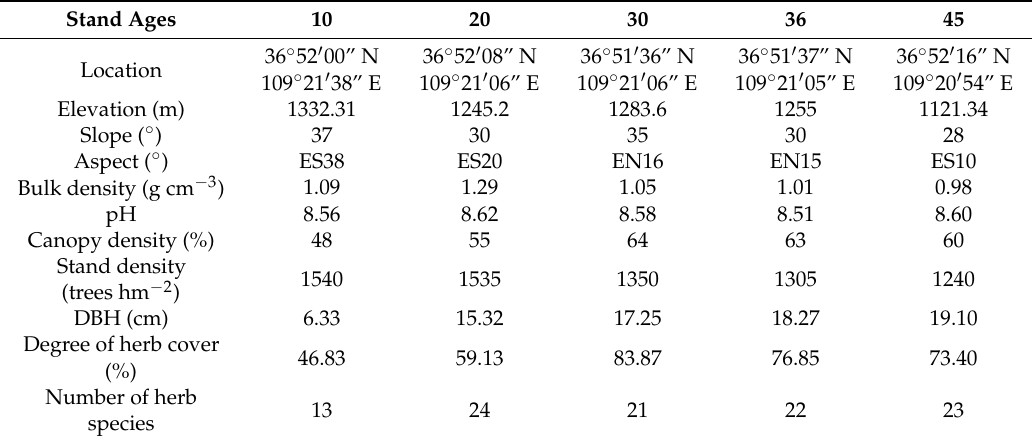
Table 1. Field site information for Robinia pseudoacacia L. plantations with different stand ages. Stand Ages